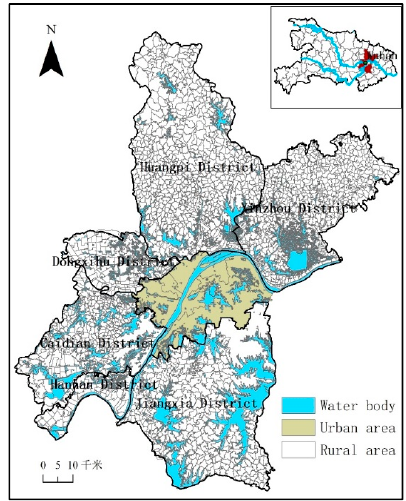
Figure 1. Location of the research area.